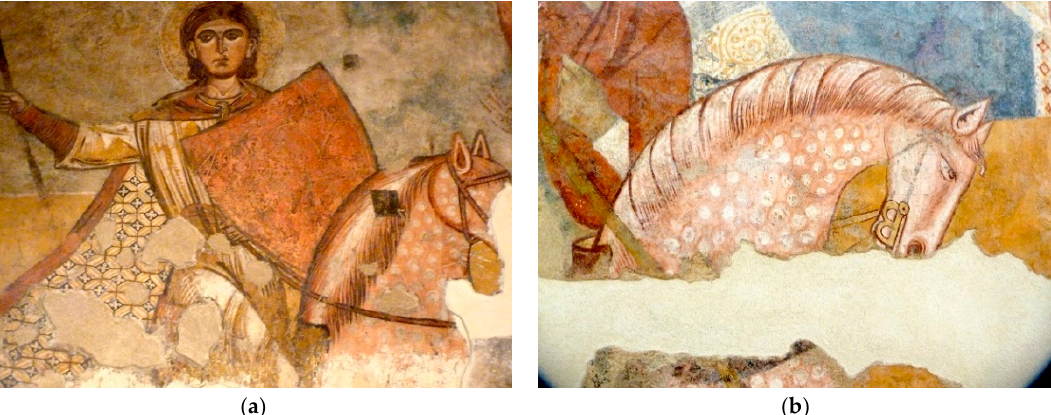
Figure 26. Warriors saints in Southern Italy. ( a ) Chapel of St John the Baptist at the Castle of Paternò (Sicily), 13th c. © Used with permission of Ángel Bartolomé. ( b ) Detail of the horse of St Theodore, (Sicily), 13th c. © Used with permission of Á ngel Bartolom é . ( b ) Detail of the horse of St crypt of St Nicholas at Faggiano (Taranto), around 1300. Bari, Pinacoteca Provinciale. © Author with the permission of the Pinacoteca Provinciale di Bari Corrado Giaquinto.